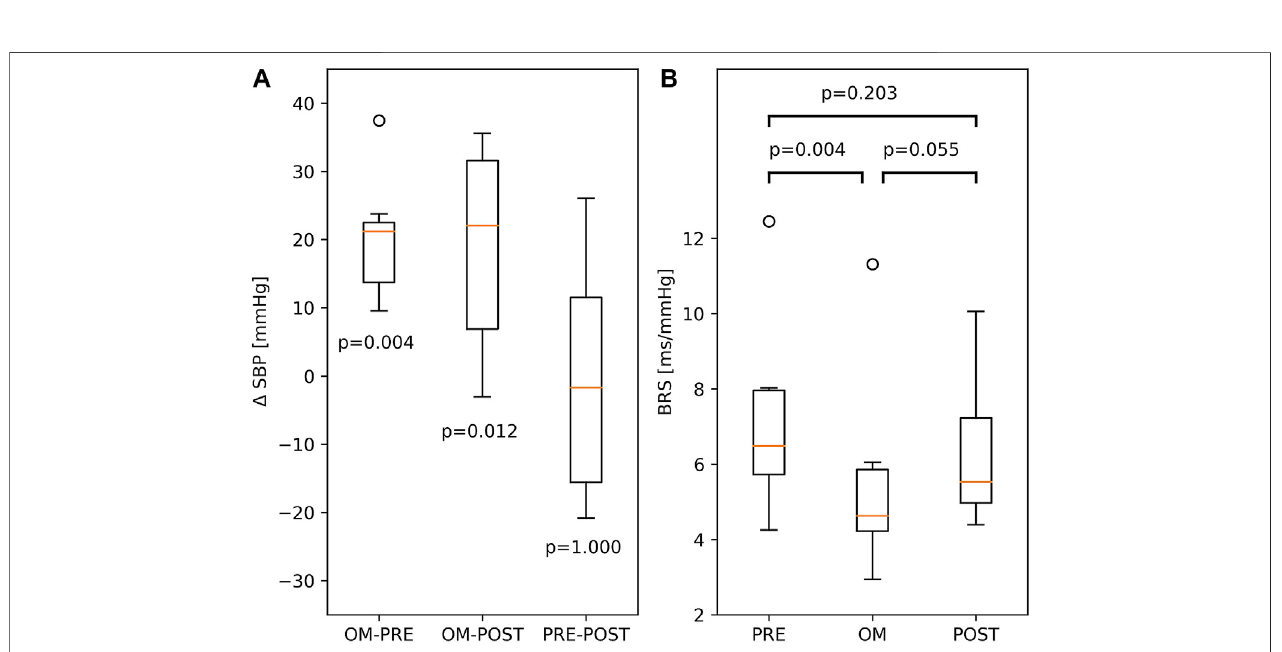
FIGURE4| (A) Boxplotsofdifferences between SBP, Δ SBP, inPRE-resting, OMand POST-resting condition. The p-values indicate theprobability of Δ SBPto be different to zero. (B) BRS during PRE-resting, OM and POST-resting condition. The probability of similar values between two conditions is indicated by the p-values above the box and whisker plot. The boxplots show median and quartiles (horizontal lines), and maximum and minimum values (whiskers).